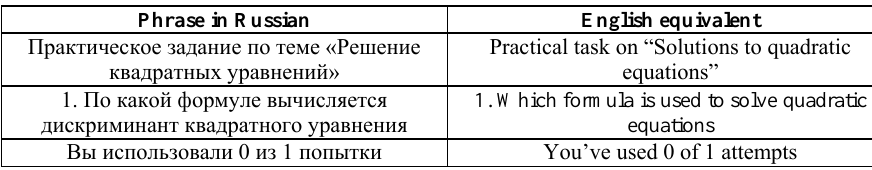
Fig. 3. Example of testing task on solutions to quadratic equation. Table 3. Contains of Figure